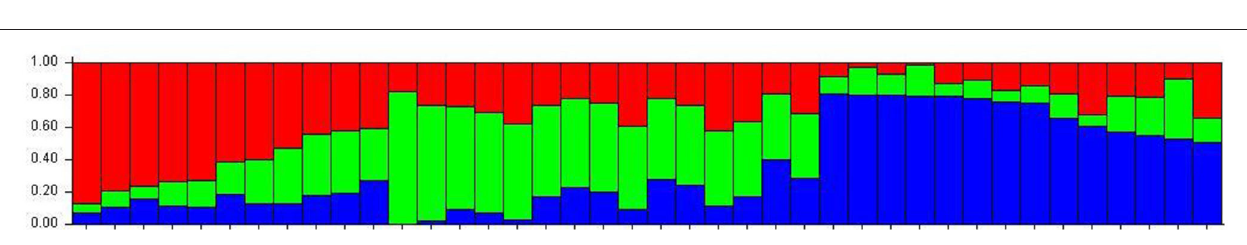
FIGURE 7 | Population structure of 39 isolates of T. indica based on 41,473 SNPs using model-based Bayesian. Dividing the population of T. indica in India into 3 subpopulations. Individuals are represented as bars, with the color of each bar indicating the degree of genetic mixing between